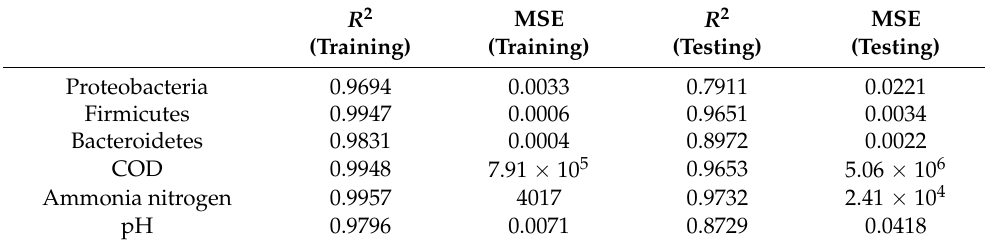
Table 6. Comparison of the RF prediction models based on the original e-nose dataset.